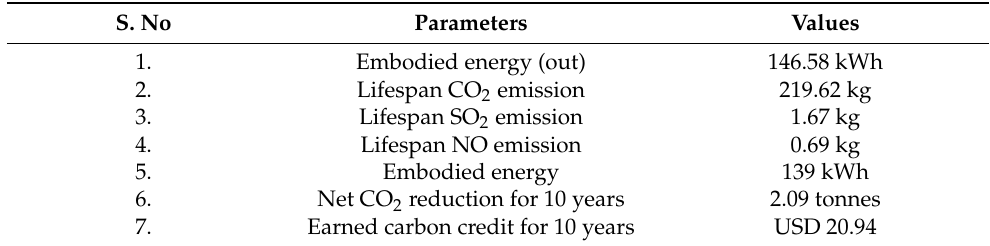
Table 6. Emissions of SO 2 , CO 2 , and NO, CO 2 reduction, and earned carbon credits for the